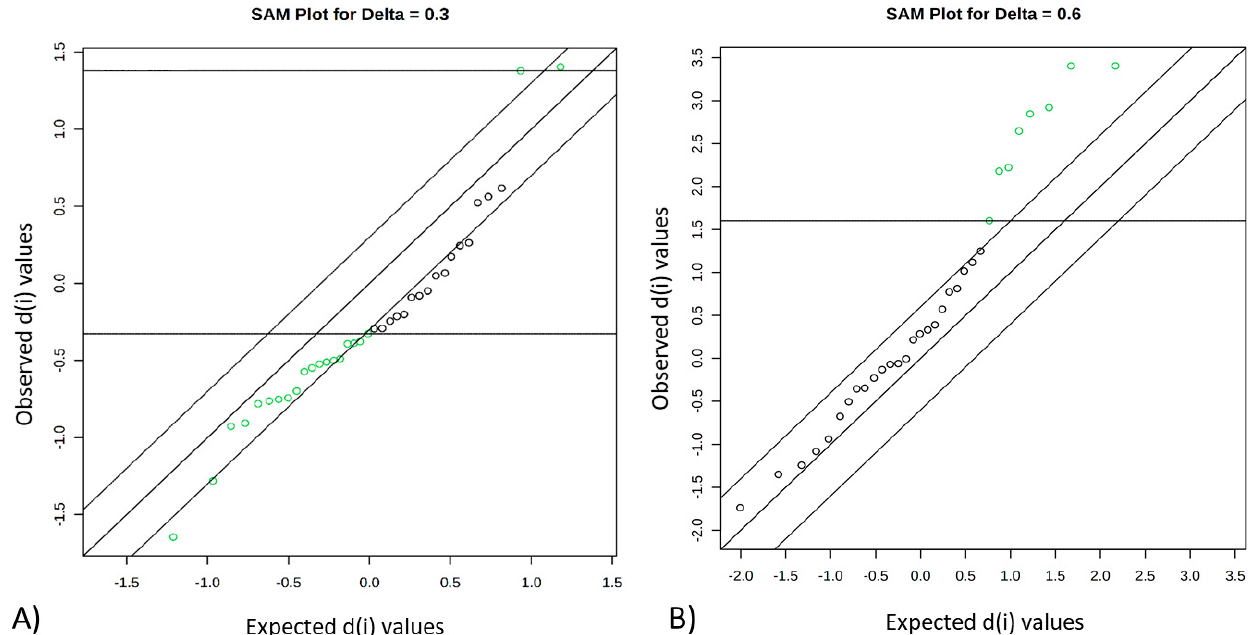
Figure 2. Significant features identified by significance analysis of metabolites (SAM). Green dots represent features that exceed the specified threshold, which represent differences in abundance among groups: FH versus PL ( A ) and FL versus PH ( B ). FH: feedlot system with high average daily gain (ADG); (FL) feedlot system with low ADG; (PH) pasture system with high ADG; and (PL) pasture system with low ADG. Table 2. Significant features representing differences among the groups identified by significance analysis of metabolites (SAM). Delta = 0.3 for FH versus PL; and Delta = 0.6 for FL versus PH comparisons. Metabolites D.Value Stdev Raw p Q.Value FH versus PL Leucine